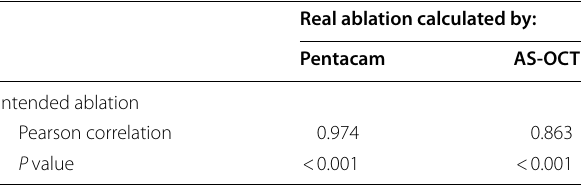
Table 5 Correlation between intended ablation with real ablation calculated by Pentacam and real ablation calculated by AS‑OCT; ( N 80): = Real ablation calculated by: Pentacam AS-OCT Intended